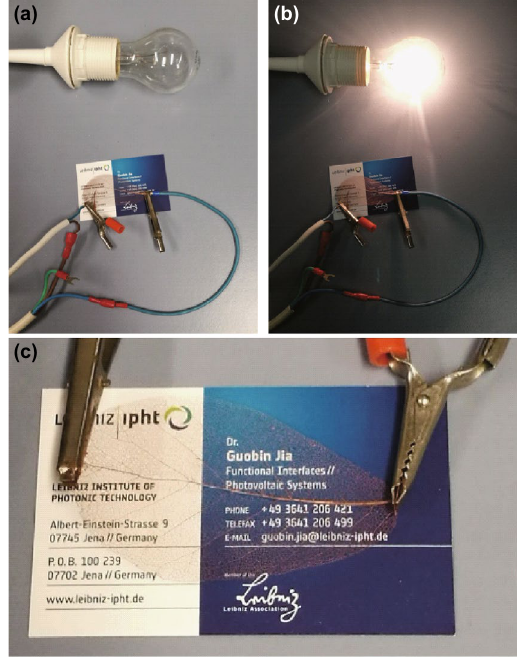
Fig. 4 Demonstration of high current density transport capability. a The 30 min as‑plated MLLV is connected between the cables. b A bulb (40 W and 230 V) shines if the switch is tuned on. c Photograph taken as the applied current of 1 A was passing through the Cu‑plated